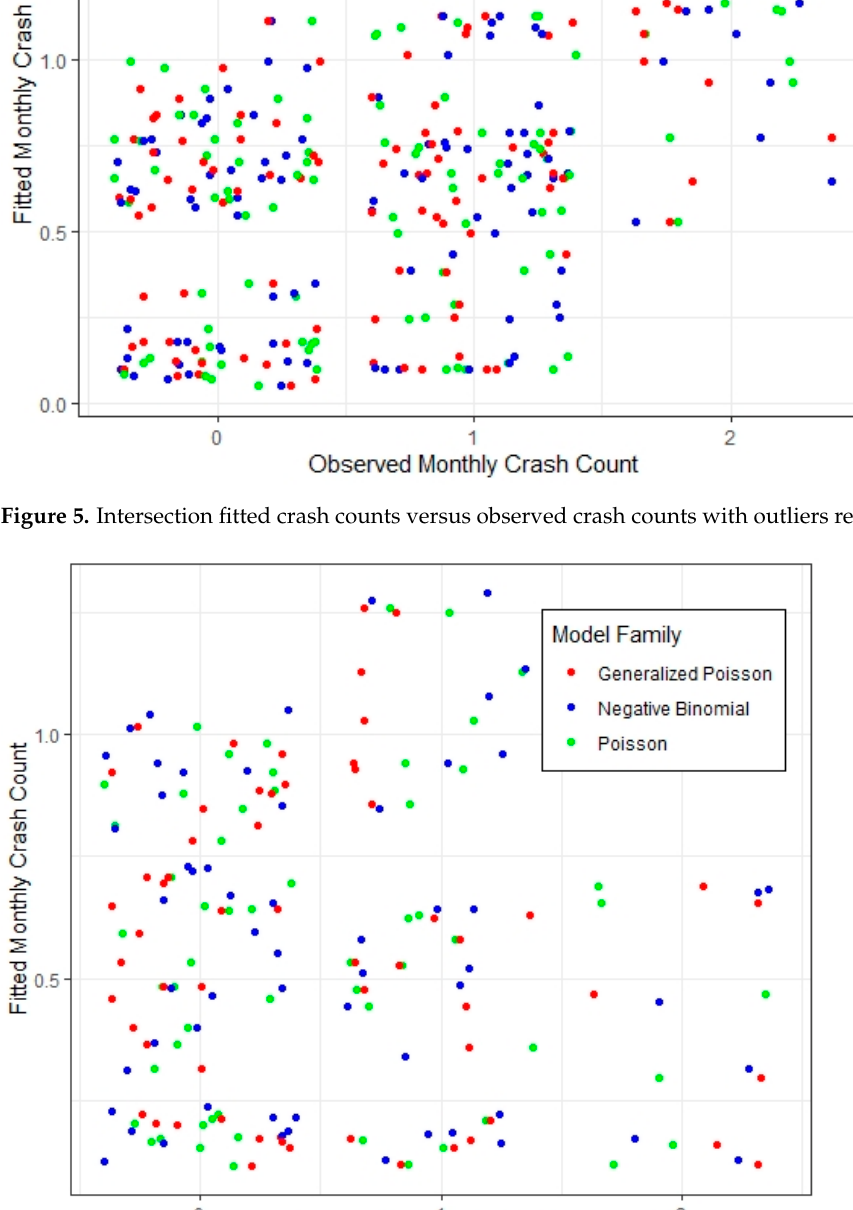
Figure 6. Segment fitted crash counts versus observed crash counts with outliers removed.